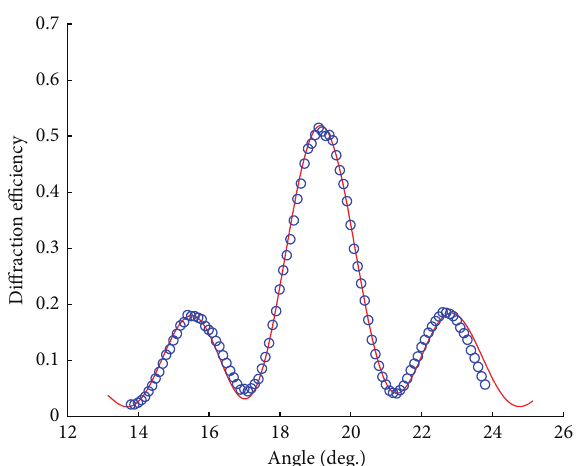
Figure 3: Diffraction efficiency as a function of the readout angle for a grating 29 𝜇 m thick, hollow circles, and the fitting provided by the algorithm using composition